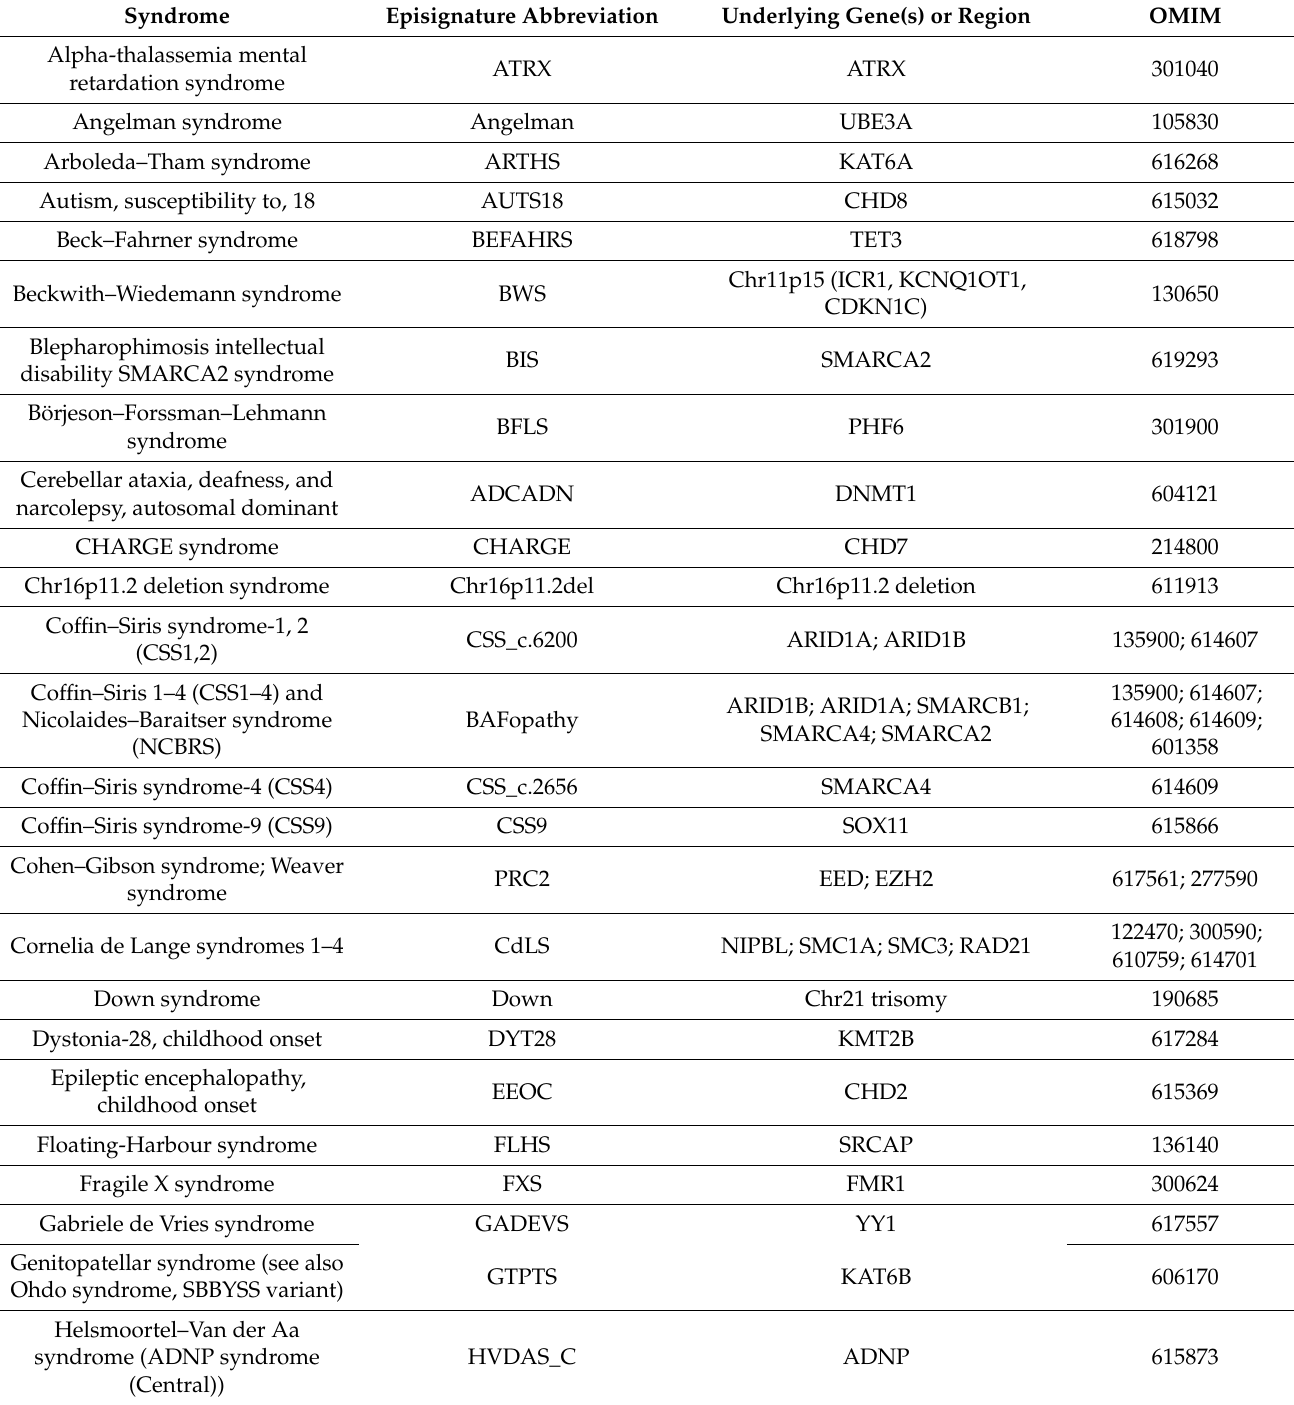
Table 1. EpiSign v3 assay gene